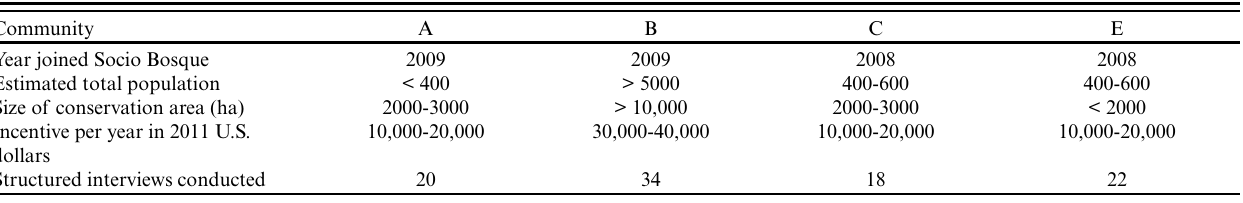
Table 1 . Demographics and information for communities interviewed in this research. Some data are reported categorically to maintain